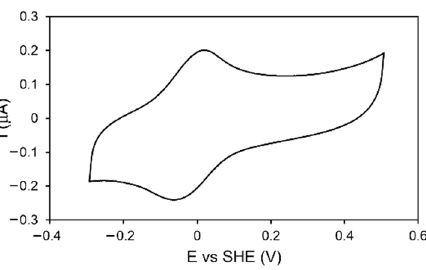
Figure 5. CV of DrEndoIII1 immobilized on Au electrodes coated with 11-mercaptoundecanoic acid (MUA) terminated SAM in 50 mM Tris-Hcl pH 8.5, 50 mM NaCl buffer. Scan rate: 50